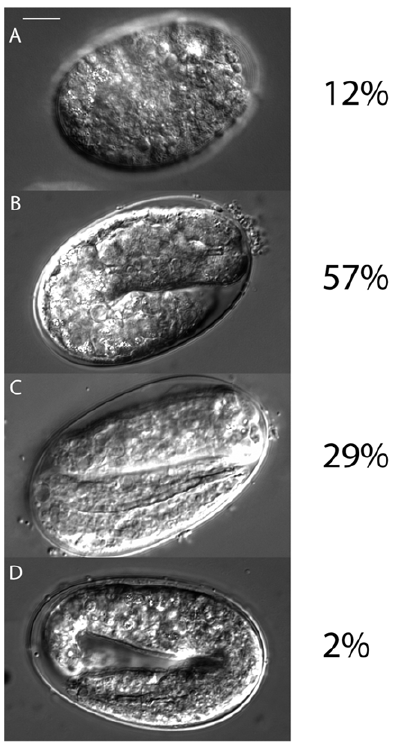
Figure 6. ALG-1 and ALG-2 are required for C. elegans embryonic development. Statistics of embryonic arrest at 15 u C (n=272). Freshly layed eggs on petri dishes were examined after a period of 12 h. A major fraction of double mutant embryos arrest during the morphogenetic phase of development ( B–D ), mainly at the 2-fold stage ( B ).